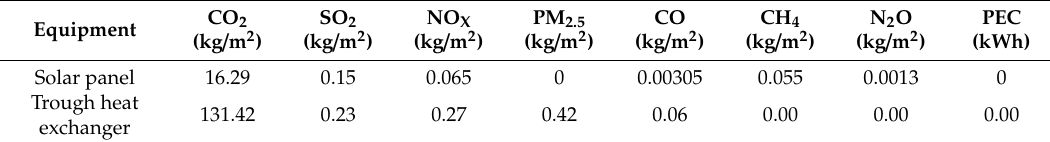
Table 10. The PEC and pollutant emissions of solar upgrading equipment.